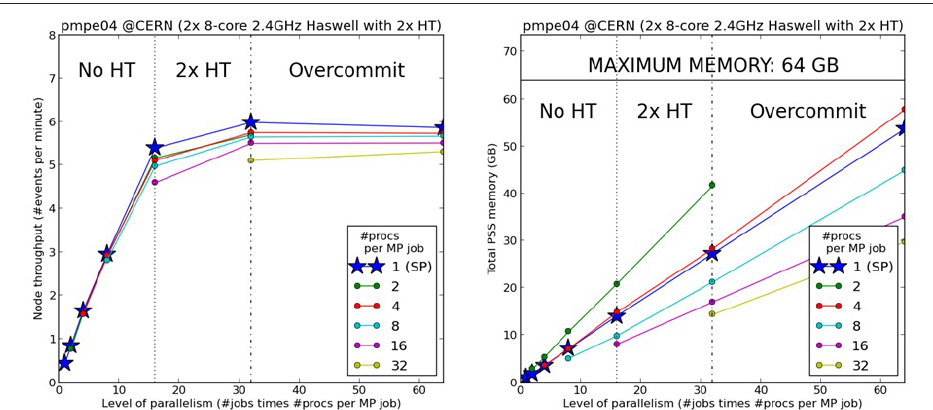
Figure 1. Gauss and GaussMP: throughput and memory on the reference Haswell node at CERN (2x8 physical cores with 2-way hyperthreading and 64 GB RAM).